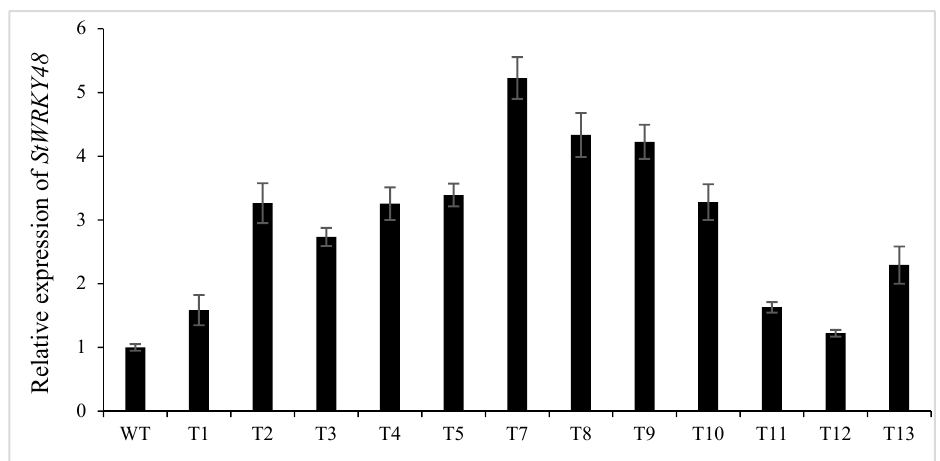
Figure 8. Expression levels of StWRKY48 in the transgenic lines. CK: wildtype plant; T1–T13: transgenic lines.